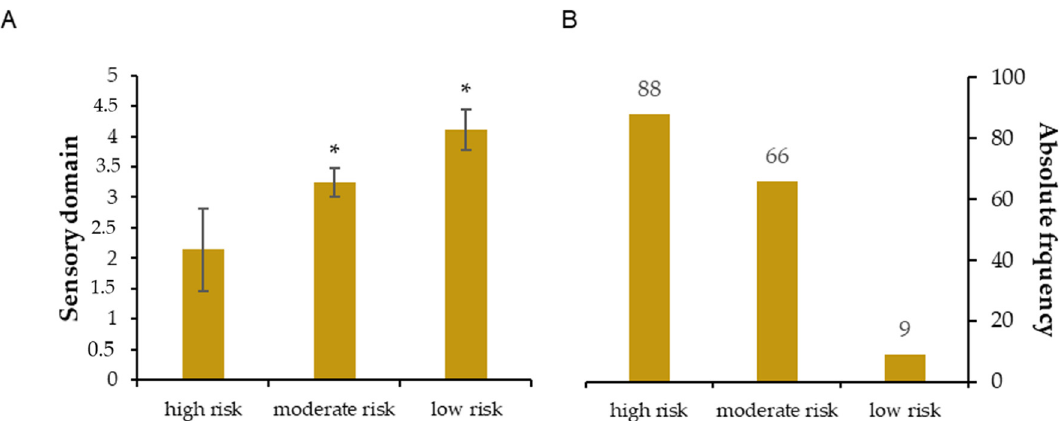
Figure 2. ( A ): Mean ± standard deviation for each risk group of the sensory domain. * p < 0.001 compared to high risk. ( B ): Absolute frequency of older adults in each risk group.